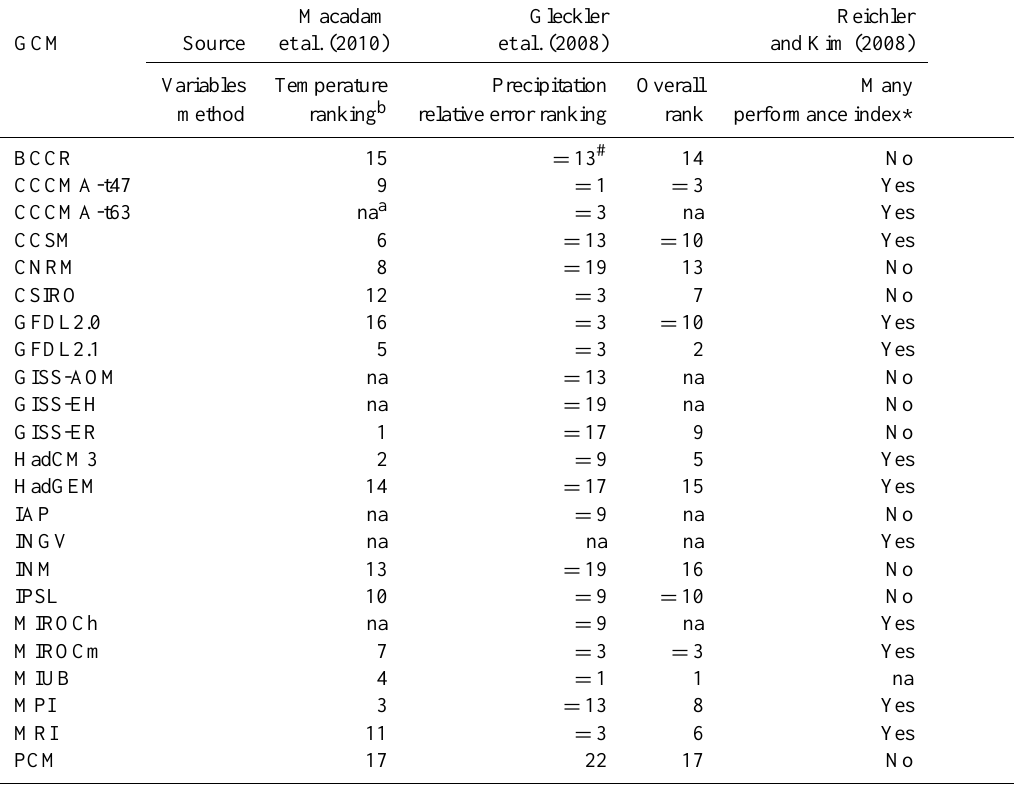
Table 3. Summary of performance of 23 CMIP3 GCMs in simulating present climate based on literature